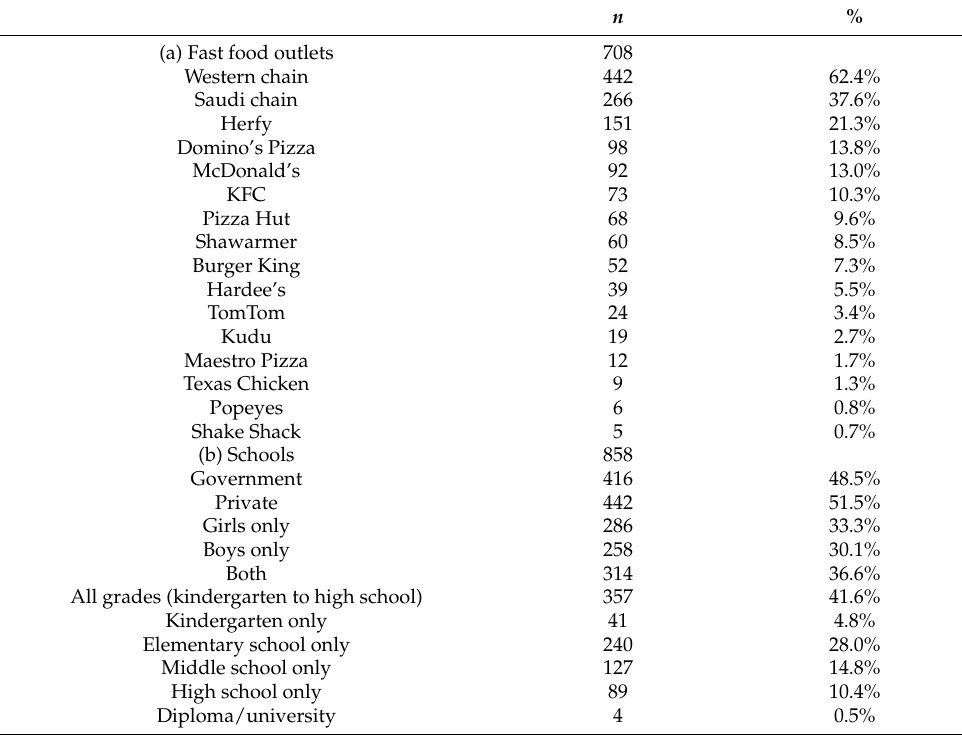
Table 1. Characteristics of sample in Riyadh